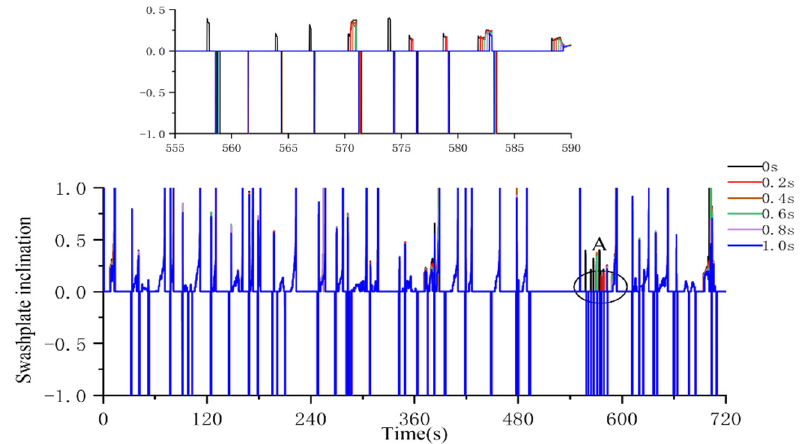
Figure 10. Variation in the tilt angle of the swashplate with different delay times under real working conditions.